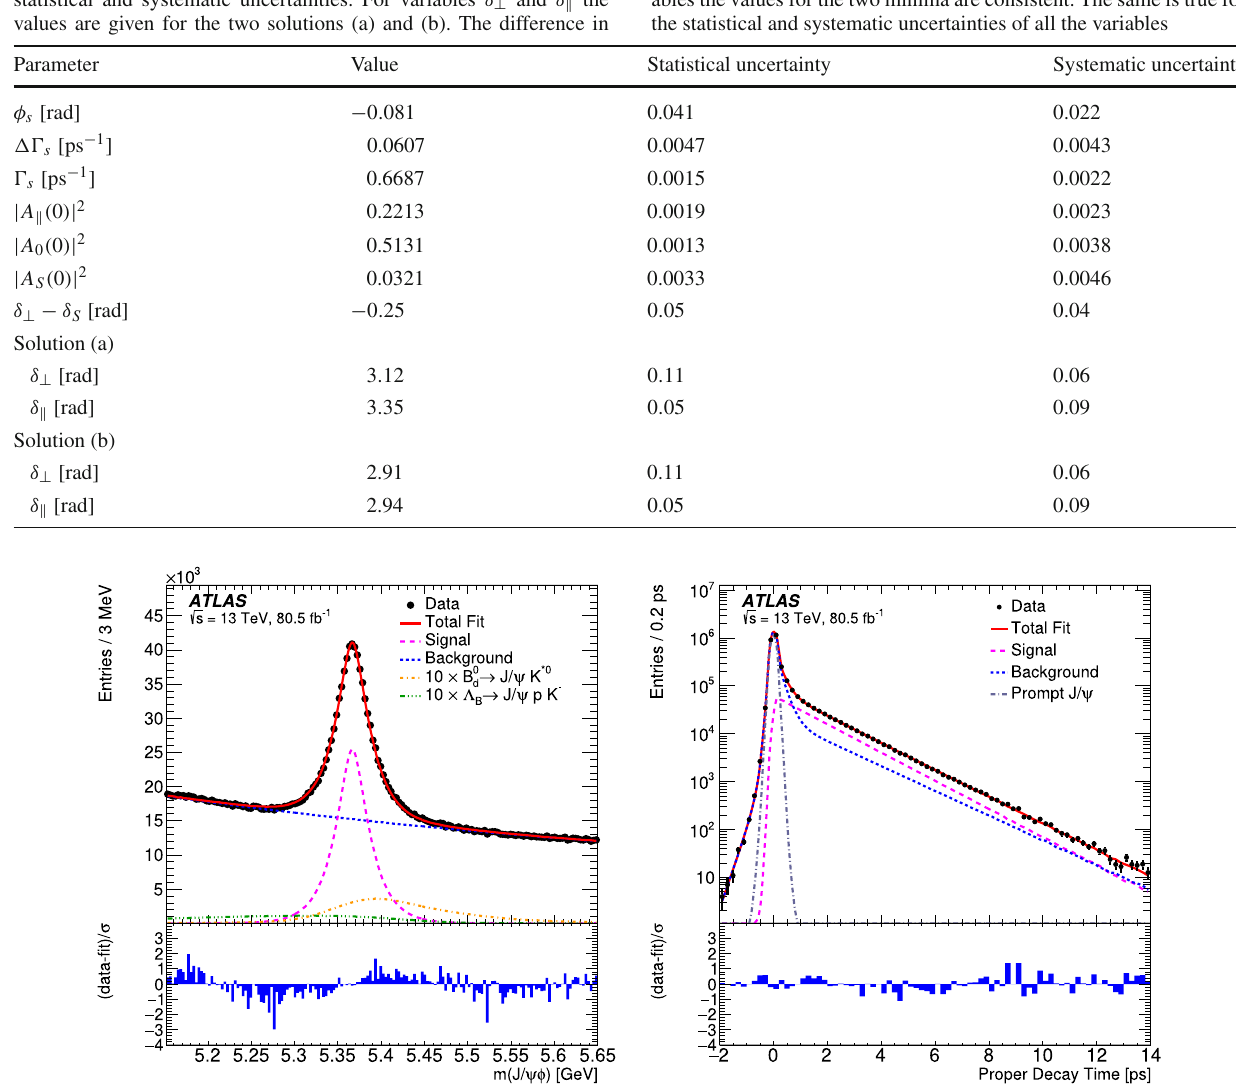
Fig. 7 (Left) Mass fit projection for the B 0 s → J /ψφ sample. The red line shows the total fit, the short-dashed magenta line shows the B 0 s → J /ψφ signal component, the combinatorial background is shown as a blue dotted line, the orange dash-dotted line shows the → J /ψ K 0 ∗ component, and the green dash-dot-dot line shows the B 0 d contribution from (cid:11) b → J /ψ pK − events. (Right) Proper decay time fit projection for the B 0 s → J /ψφ sample. The red line shows the total